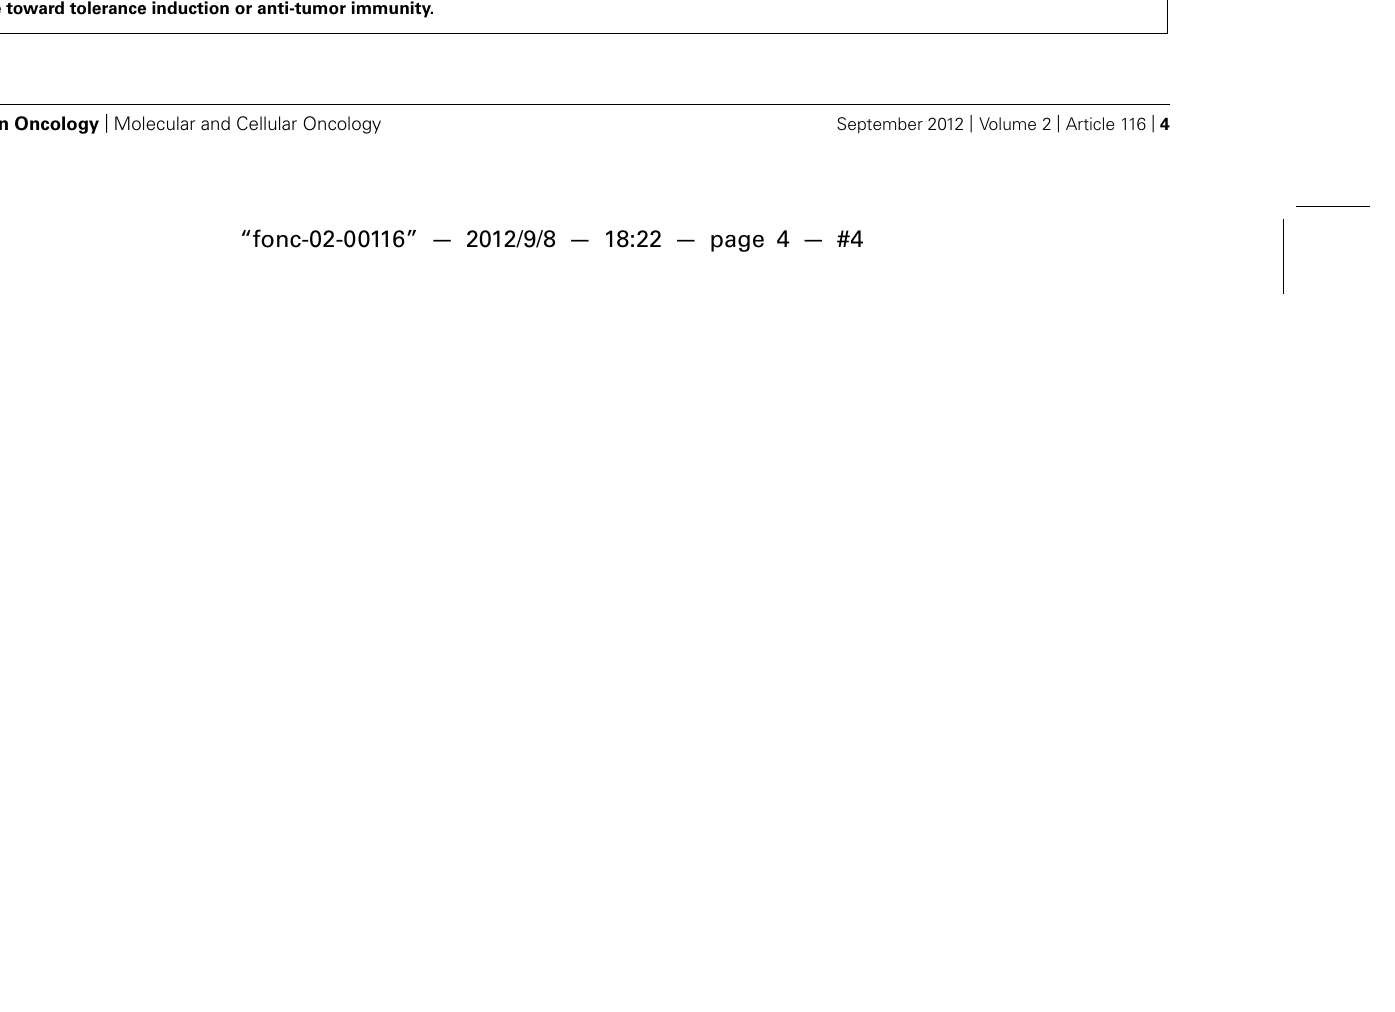
Frontiers in Oncology | Molecular and Cellular